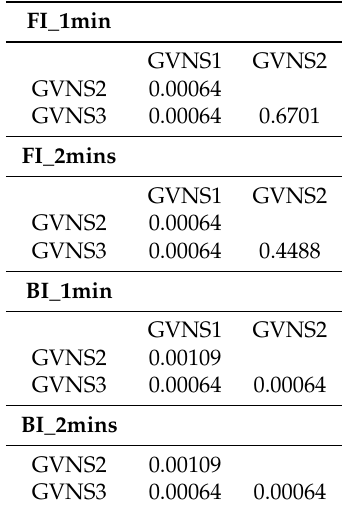
Table 14. KPairwise comparisons using Wilcoxon signed rank test.